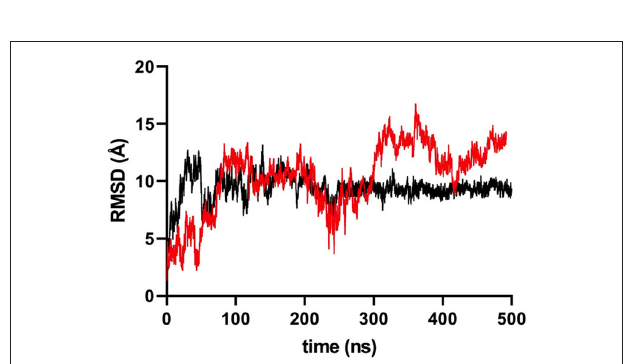
FIGURE 2 | RMSD variation in MICA variant simulations. Black colored line represents MICA*004 (Arg181 variant), while red colored line